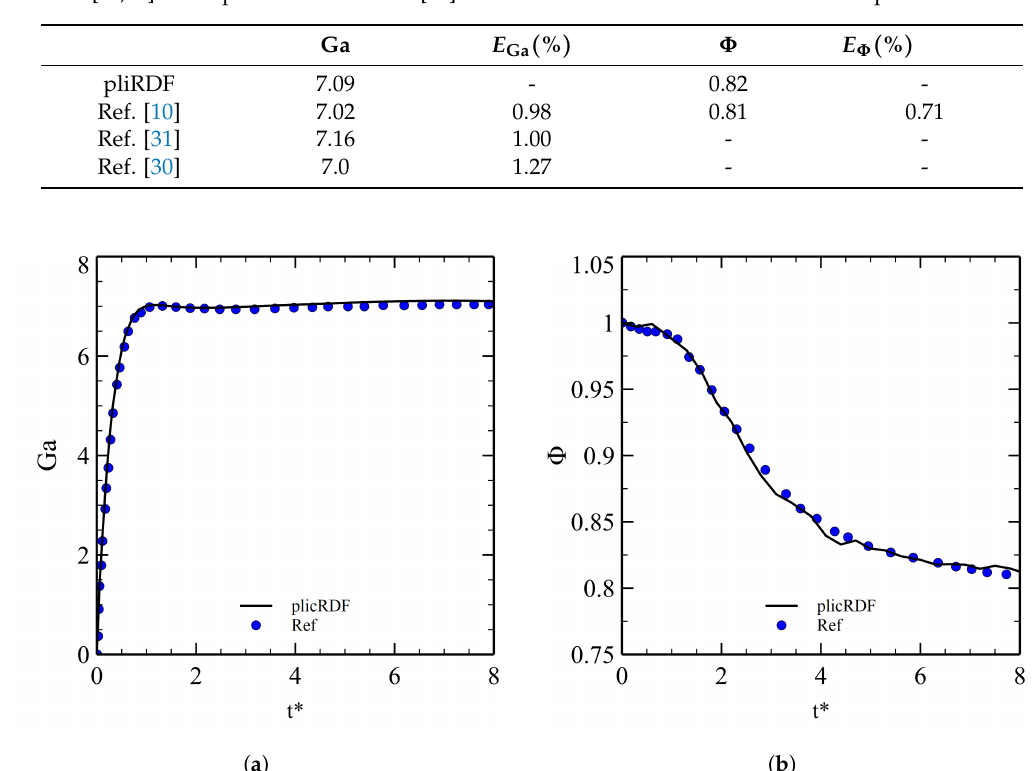
Table 10. Benchmark results for the 3D C1 case (M3 mesh) compared against numerical data from